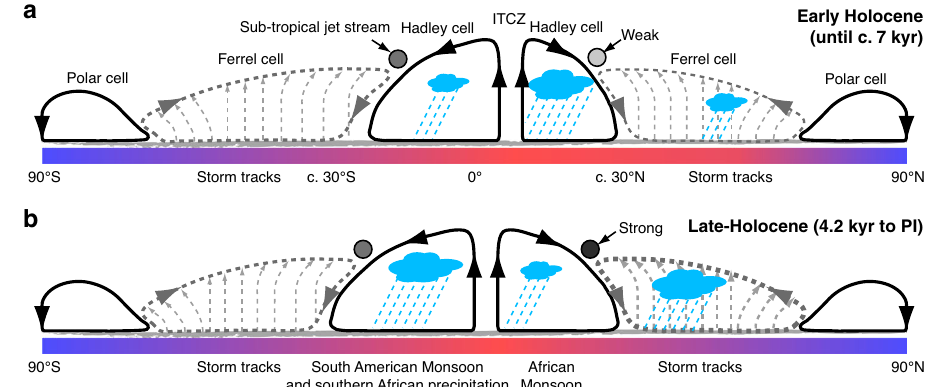
Fig. 1 Schematic illustration of the general circulation of the atmosphere for early and late Holocene latitudinal insolation gradients. a Schematic representation of the mean early Holocene atmospheric circulation (until c. 7 kyr) in the Atlantic sector, showing the latitudinal positions of the monsoon regions, mid-latitude storm tracks and the subtropical jet stream. During this period, the Northern Hemisphere extra-tropics warmed more and received more insolation relative to the Southern Hemisphere. This induced higher precipitation in the African Monsoon region, a northward migration of the intertropical convergence zone (ITCZ) and lower precipitation in the Northern Hemisphere mid-latitudes and in the realm of the South American Monsoon. b Same as in a but for the late Holocene (after c. 4.2 kyr) until pre-industrial (PI) times. During this period, a stronger temperature gradient between the low-latitudes and high-latitudes in the Northern Hemisphere, as well as changing latitudinal insolation gradients induced increased precipitation in the mid- latitudes and in the realm of the South American Monsoon, while precipitation decreased in the African Monsoon